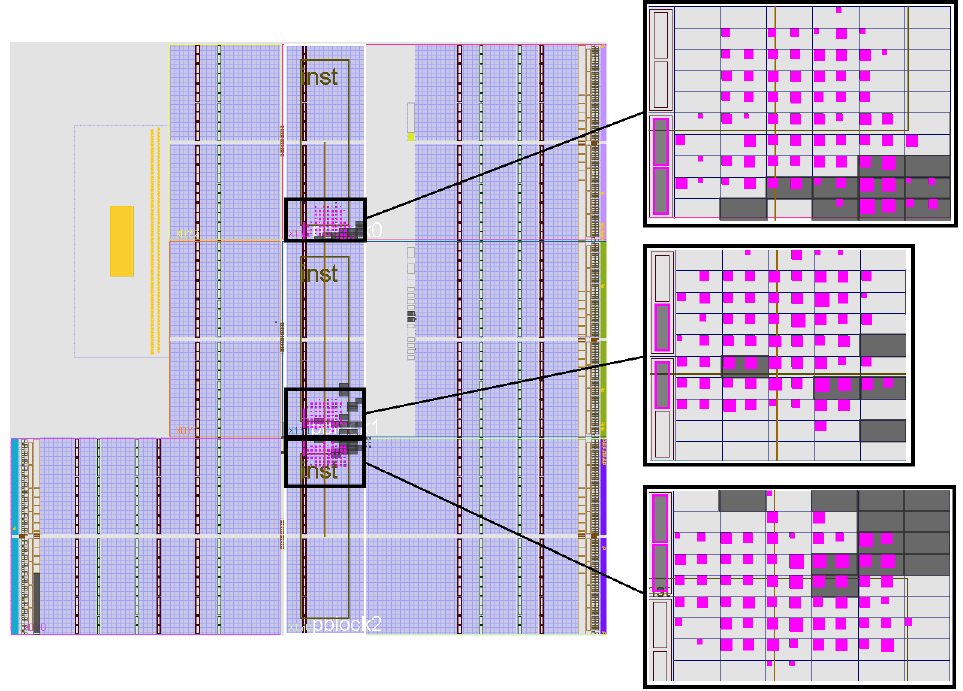
Figure 10. Device image from Vivado of a TMR design without placement